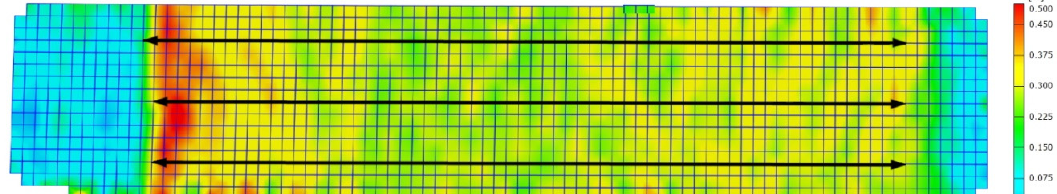
Figure 1. Visualization of the strain in loading direction in specimen 5 for the last frame before the fracture. Three lines each were defined to obtain the strain in the area of the porous structure. Using the frame with the largest elongation (last frame before fracture), the transition between grip section and porous structure is best distinguished.